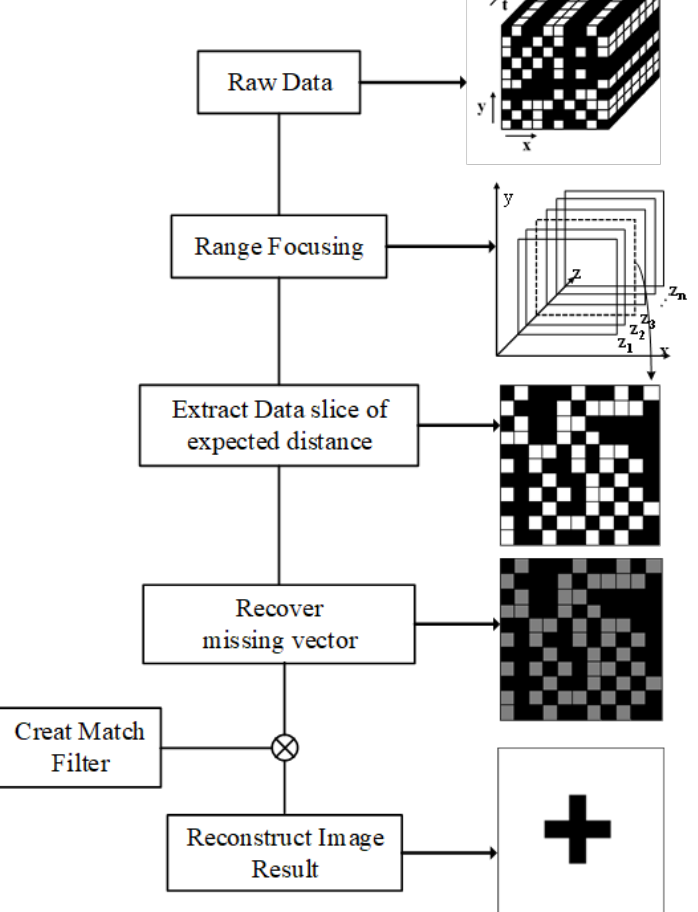
Figure 5. Flow diagram of spatial under-sampling image reconstruction method based on amplitude and phase compensation.